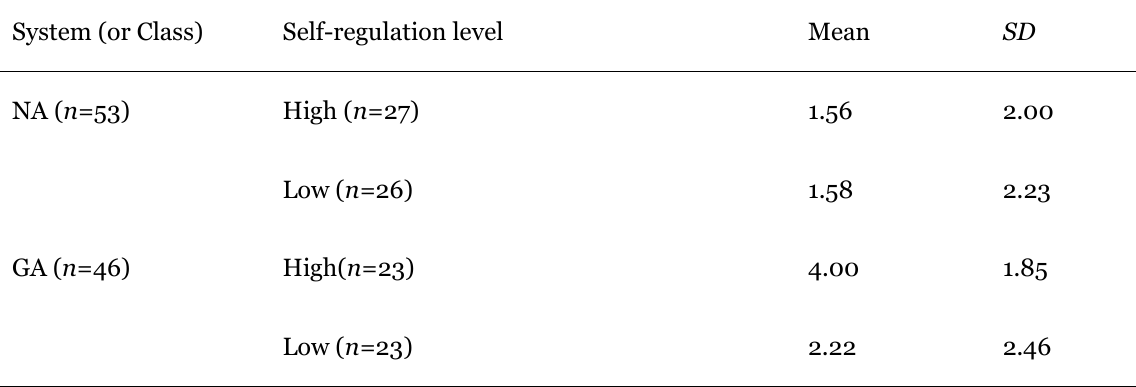
Descriptive Statistics of the Number of Taking Assessments (n = 99)